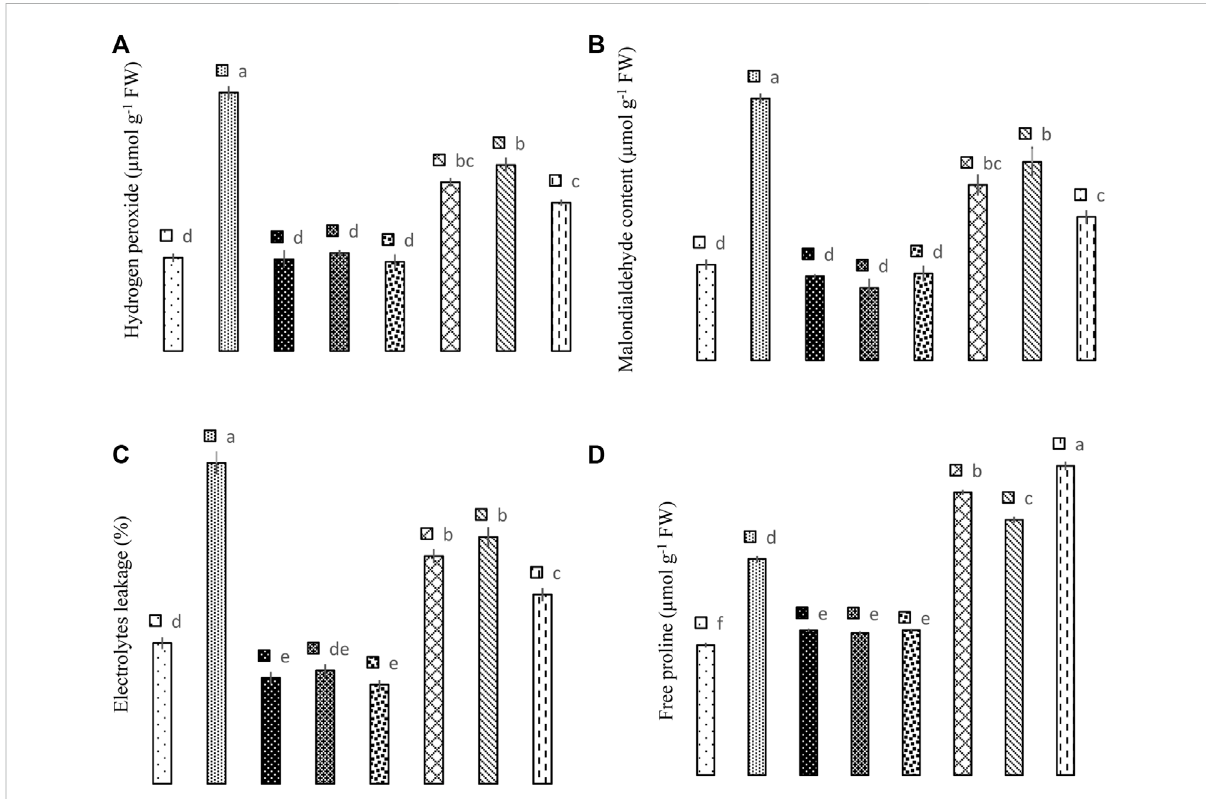
FIGURE 4 Effectofsoleandcombinedapplication ofsiliconandbiocharonhydrogenperoxide (A) ,malondialdehydecontent (B) ,electrolytesleakage (C) , and free proline (D) of maize under As toxicity. Bars sharing the same letter do not have a signi fi cant ( p < 0.05) difference. Error bars show the standard error of